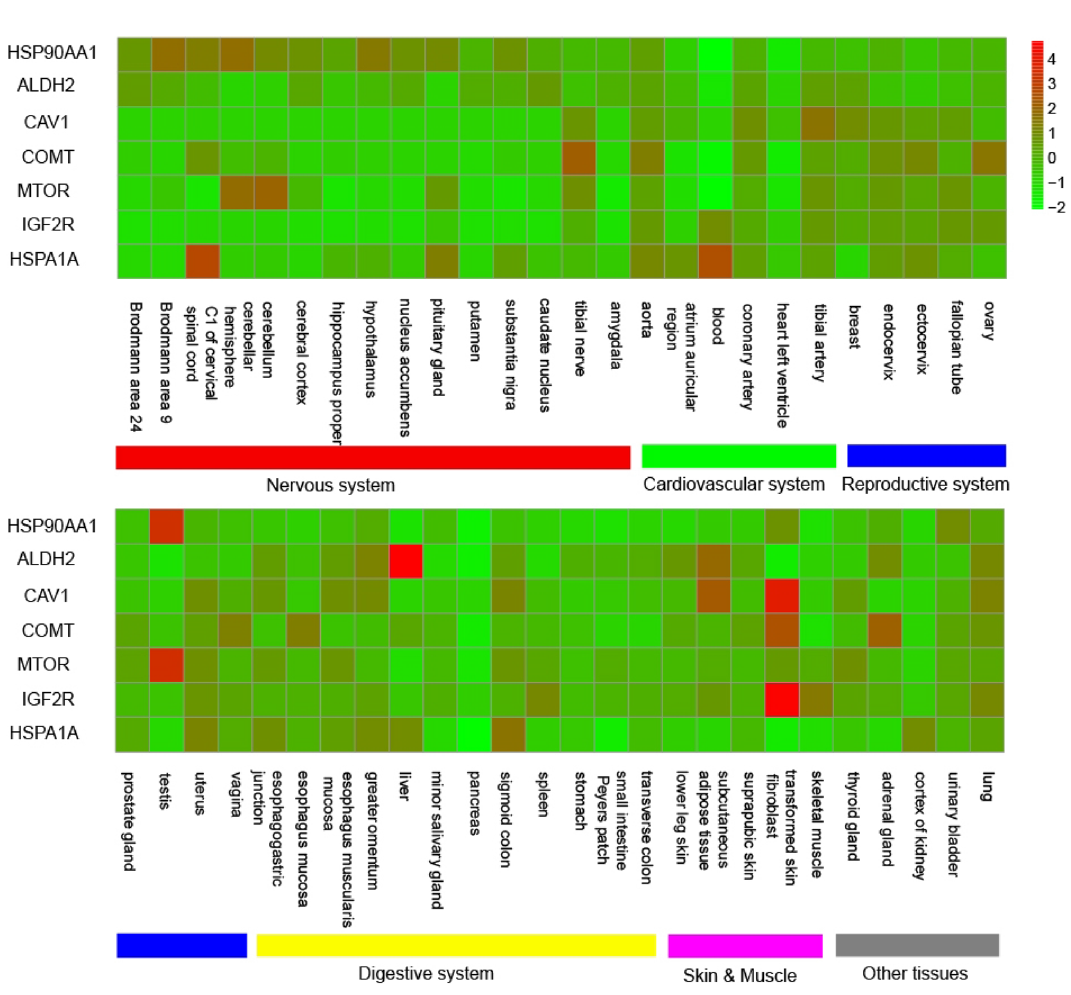
Figure 4. The expression of seven genes in 52 human tissues. The heat map listed the normalized expression value of genes in tissues according to the legend in the top right. The genes were shown in the left side of the figure. The tissues were shown at the bottom of the figure and were organized by systems (colored